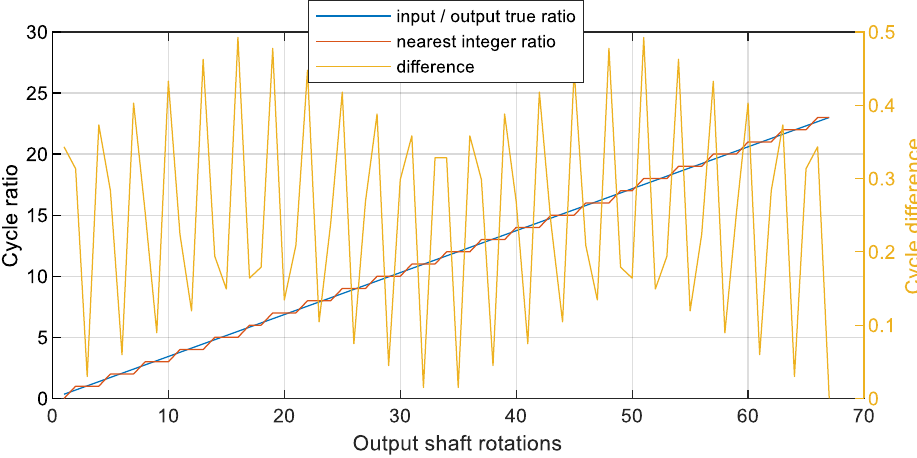
Figure 12. Ratios of cycles for the first 67 rotations of the output shaft.